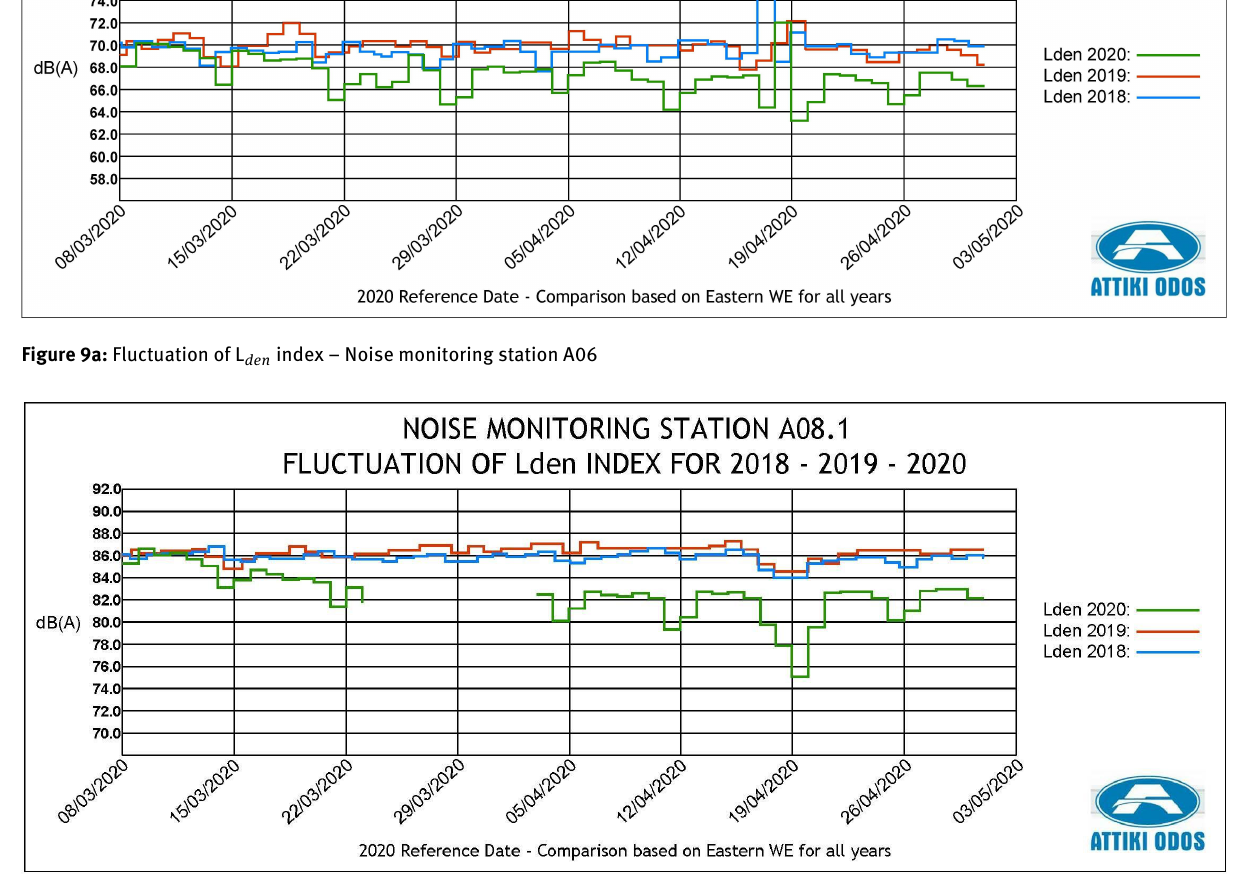
Figure 9b: Fluctuation of L den index – Noise monitoring station A08.1